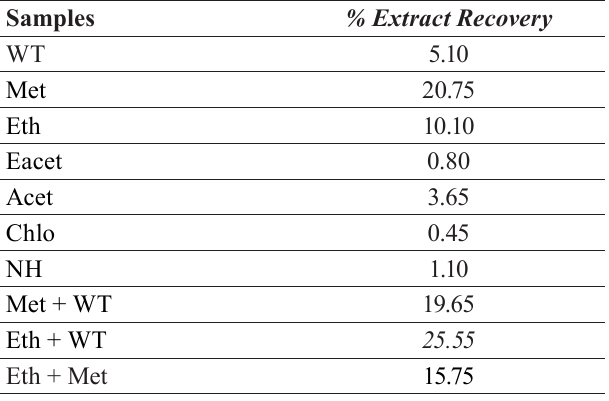
TABLE I - P ercent extract recovery of E. intermedia using different solvents Samples